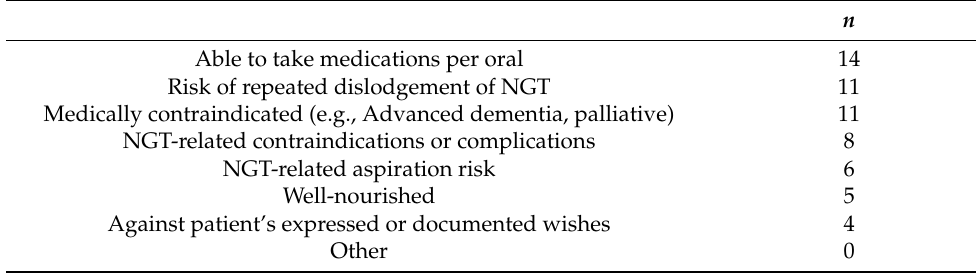
Table 3. Enteral Tube Feeding Decision Support tool indicated barriers to ETF.